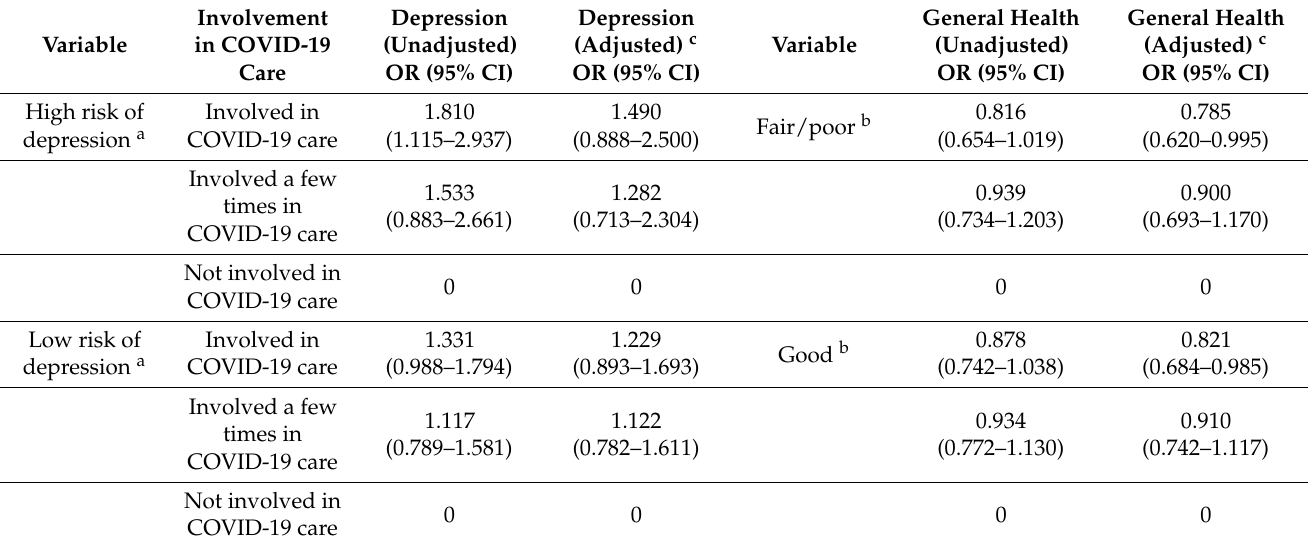
Table 2. Associations between involvement in COVID-19 care and health consequences (general health and depression) among health-care workers (N = 3488).